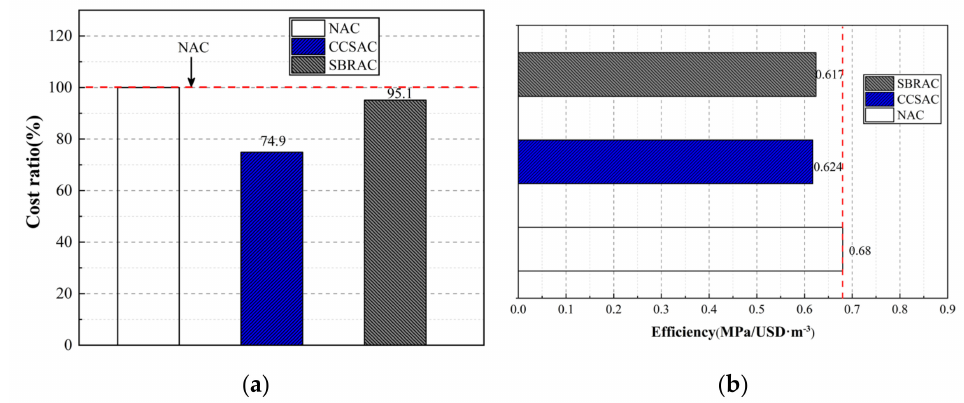
Figure 9. ( a ) Cost ratio of concretes. ( b ) Compressive strength − economic